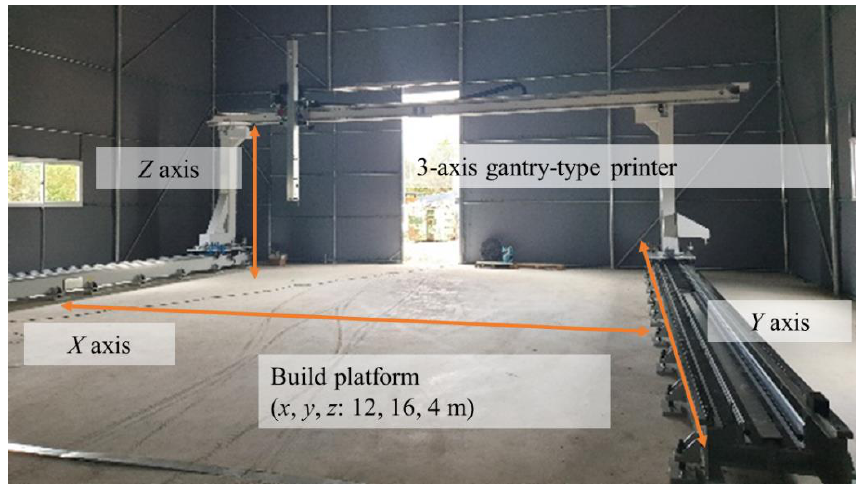
Figure 5. Gantry robot for 3DCP.